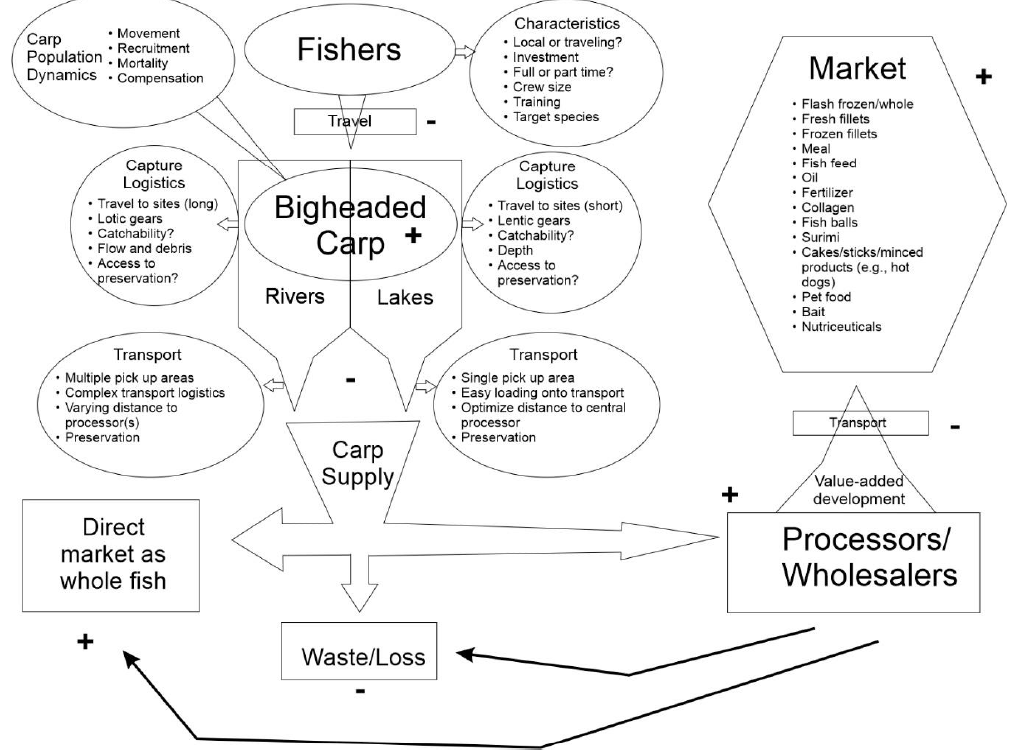
Figure 1. Conceptual model of a fishery for bigheaded carps in the rivers and lakes of the invaded south and north central United States. Economic factors affecting fishers will influence the species composition and biomass of bigheaded carp available to the supply chain. Transportation and markets will drive the level of harvest. Each component along the supply chain has costs ( − sign) and economic gains (+) that determine how much fish are removed from the environment.